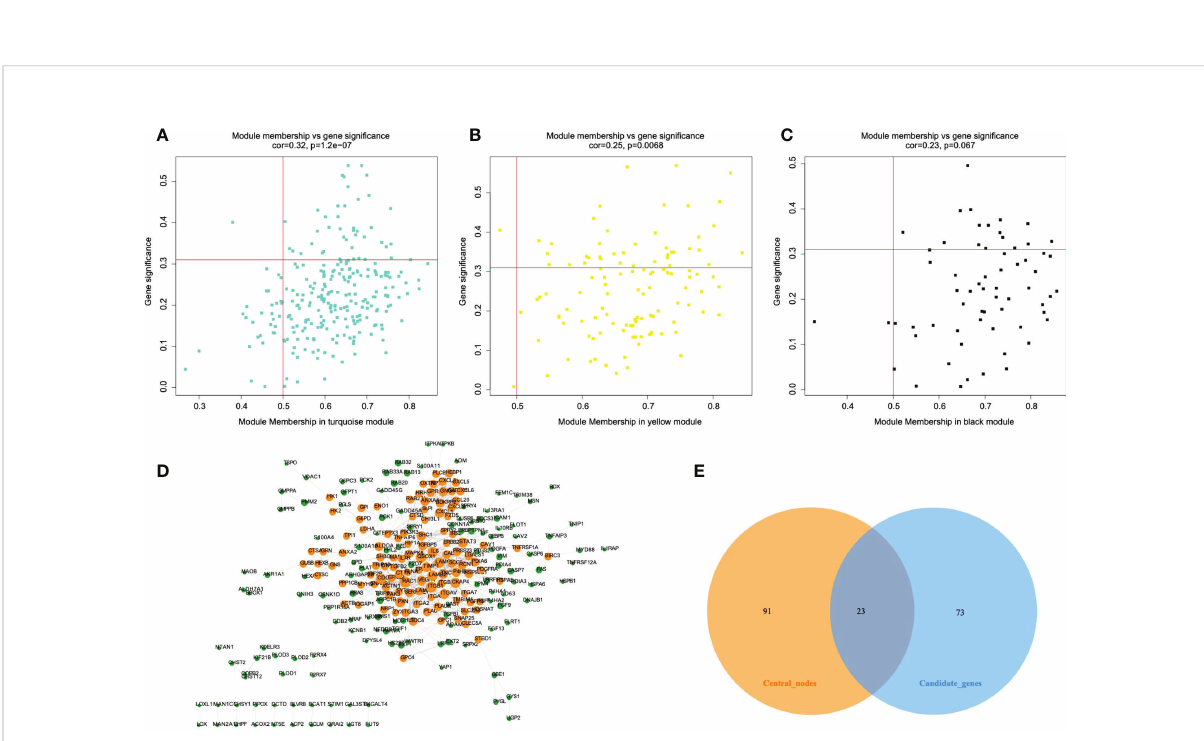
FIGURE 4 Protein-protein interaction (PPI) network construction and identi fi cation of hub genes. A-C. The scatterplot of gene signi fi cance vs. module membership in the key co-expression modules, presented with turquoise (A) , yellow (B) , and black (C) colors respectively. (D) Establishment of PPI network based on genes from key modules. Yellow color represents network core genes. (E) The Venn diagram shows the intersecting genes of module core genes and network core